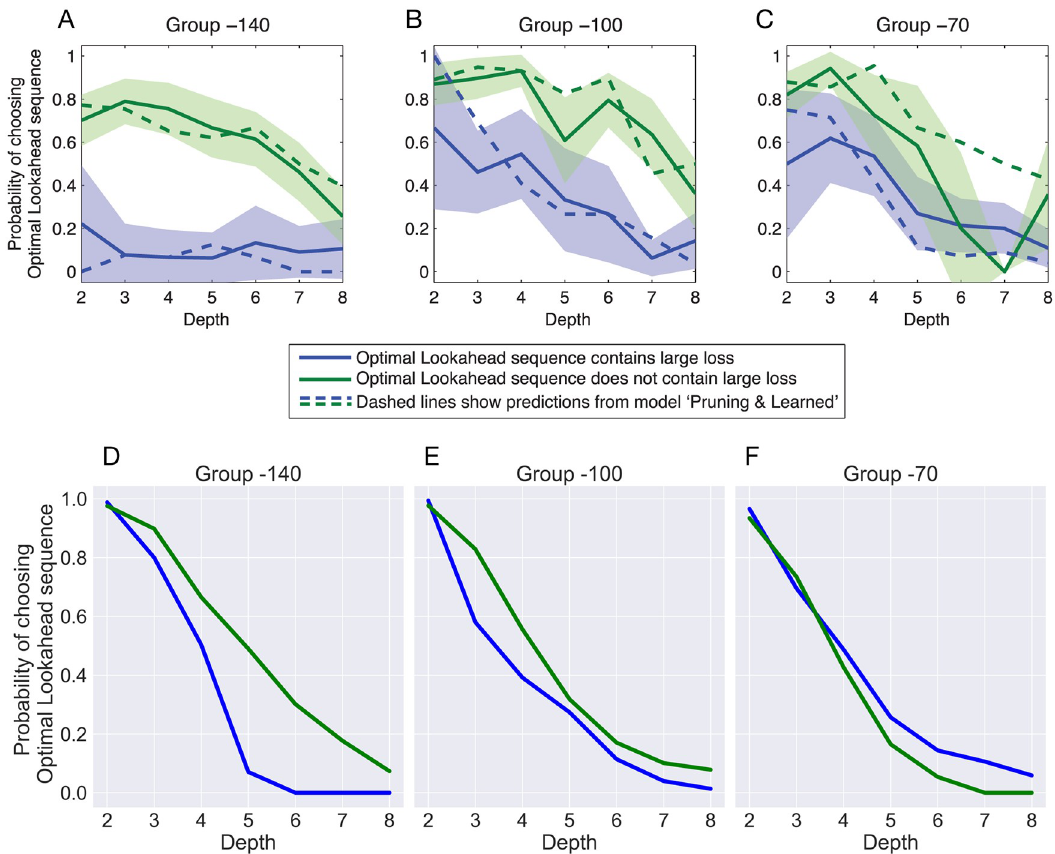
Fig 5. The top panels show the effect of different factors on choosing the optimal sequence of action. The panels are adapted from [12]. The x-axis denotes the number of actions the subjects were supposed to take, which determines the maximum depth of the search tree. The y-axis denotes the probability of choosing the Optimal Lookahead sequence. The blue lines represent the condition that the optimal sequences of actions included a big loss, and the green lines represent the condition that the optimal sequence of actions did not include a big loss. The amount of big loss is varied among the panels, and is mentioned by Group X on top of the panels, in which X denotes the amount of big loss (X = -140, -100, -70). The bottom panels are similar to the top panels but using the data obtained from the simulations of the model in the same